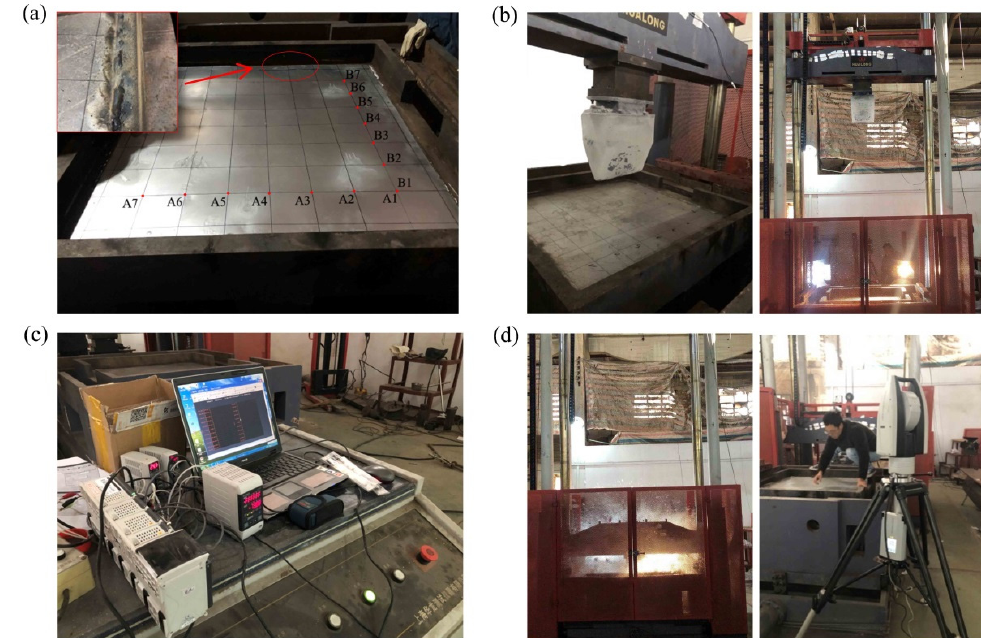
Figure 7. Photos of the test setup: ( a ) Installing the test piece; ( b ) Installing the ice indenter and raising it to the target height; ( c ) Signal acquisition device; ( d ) Dropping the ice indenter and measuring the deformation. Table 3. Information of falling weight impact test.